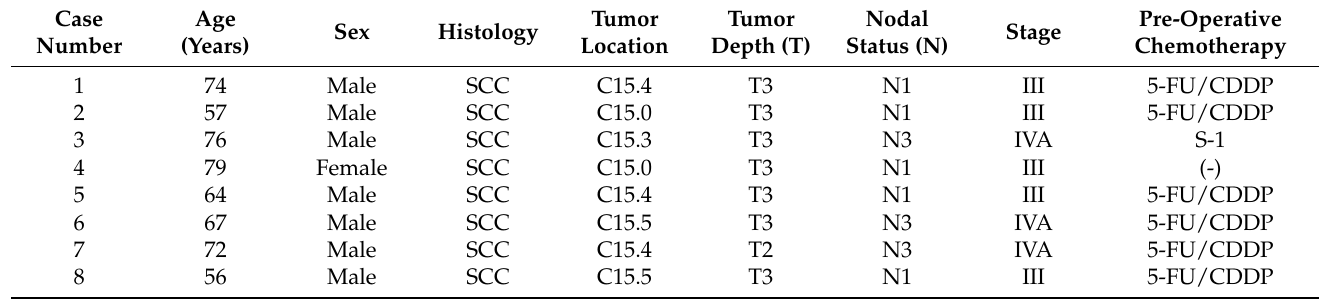
Table 1. Clinicopathological features of enrolled patients with esophageal